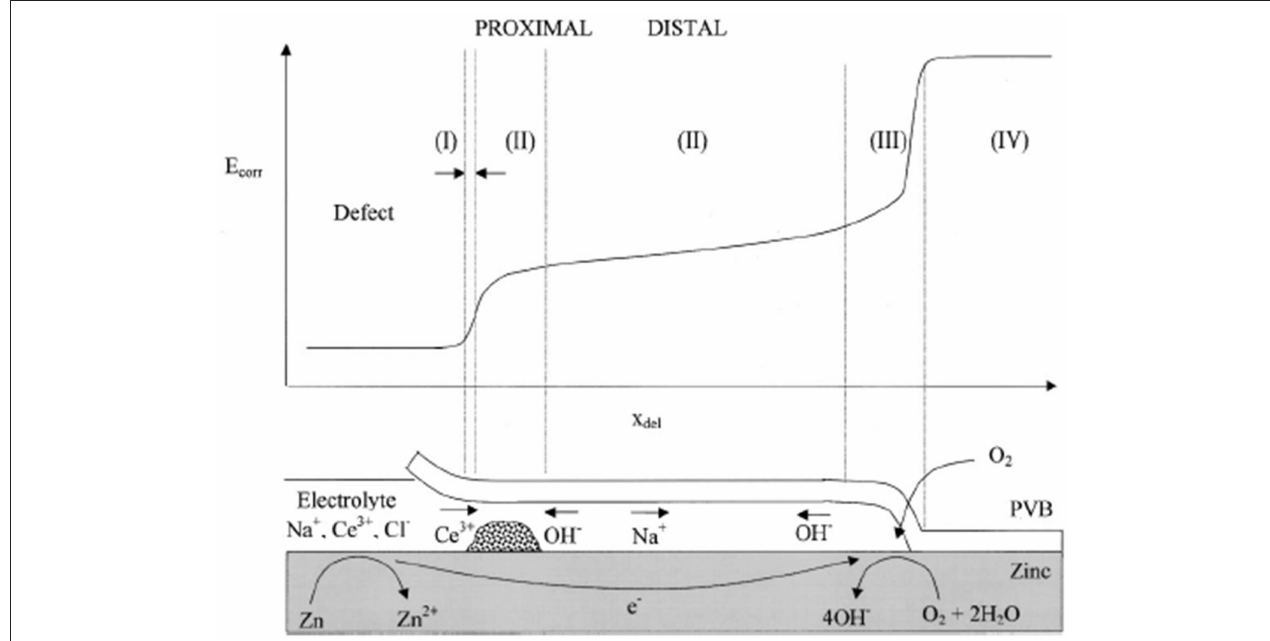
FIGURE 3 | Schematic representation of the corrosion-driven cathodic delamination cell showing correspondence with various regions of the time-dependent E corr vs. ( x ) profile under conditions where the external electrolyte contains Ce(aq) (Bierwagen et al., 2007). Demonstrates that in-coating cerium lowers the delamination rate where Ce 3 + cations react to precipitate as Ce(OH) 3 . t 1 / 2 kinetics are shown where transport of ions from the defect to the delamination site are the rate determining step. Reproduced with permission.